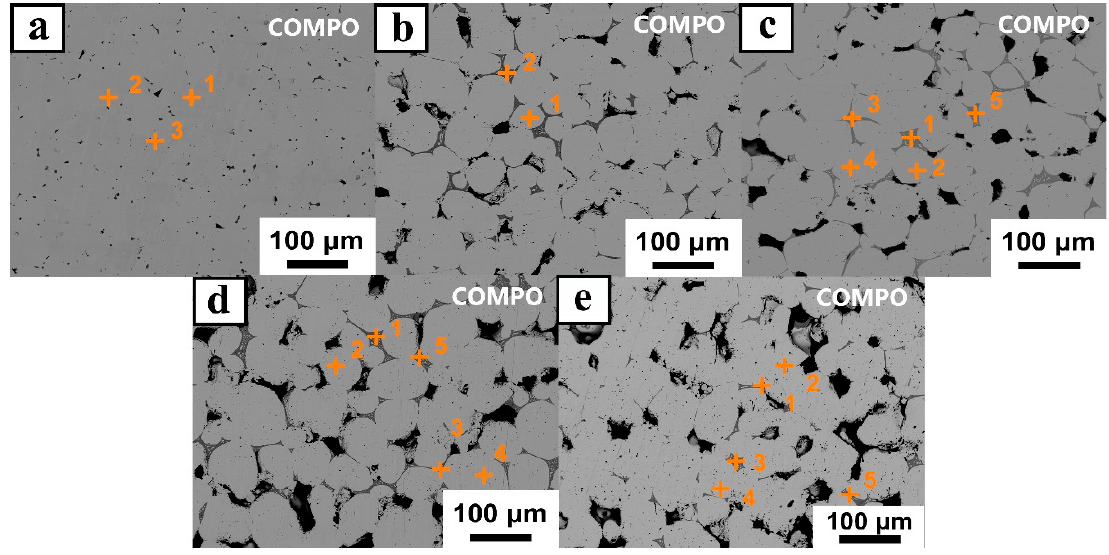
Figure 10. Schematic diagram of positions for EPMA measurements of ( a ) O-1; ( b ) O-2; ( c ) O-3; ( d ) O-4; ( e ) O-5.